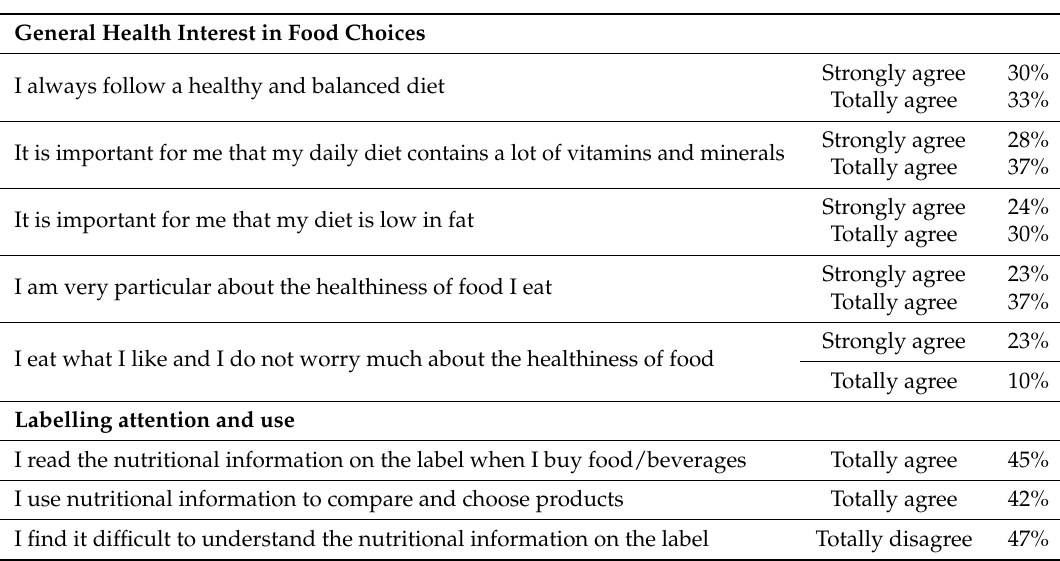
Table 1. Participants’ health interest in food choices, attention towards and use of nutritional labels.